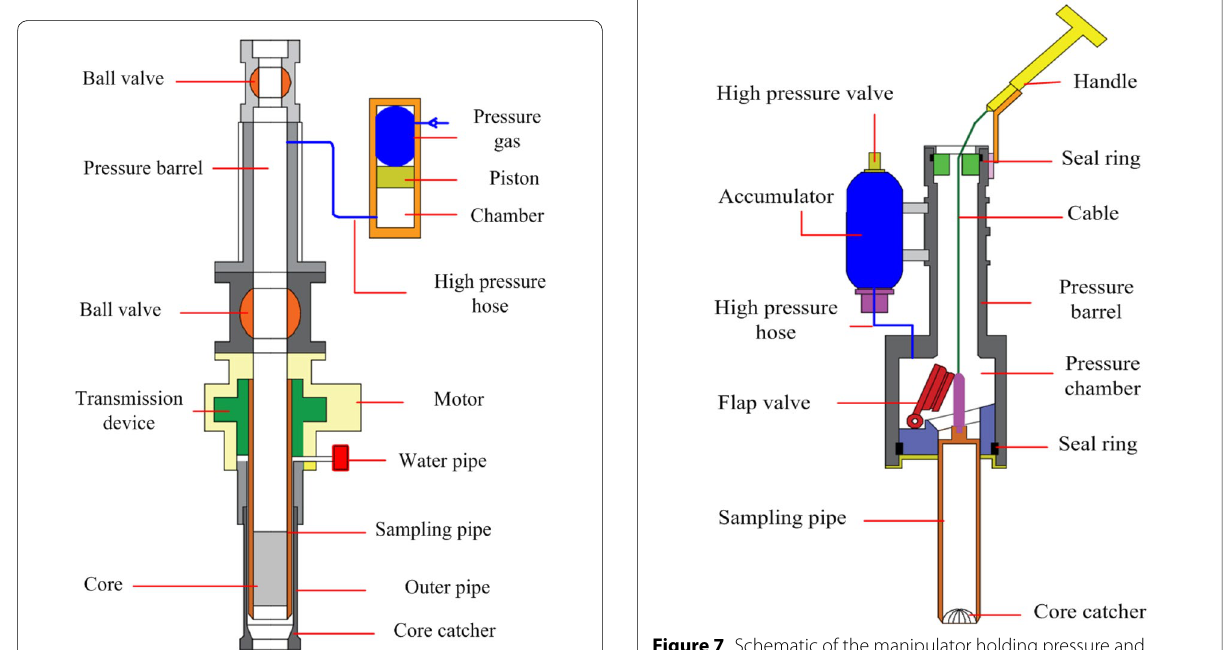
Figure 6 Schematic of the tight rock corer (TRC)